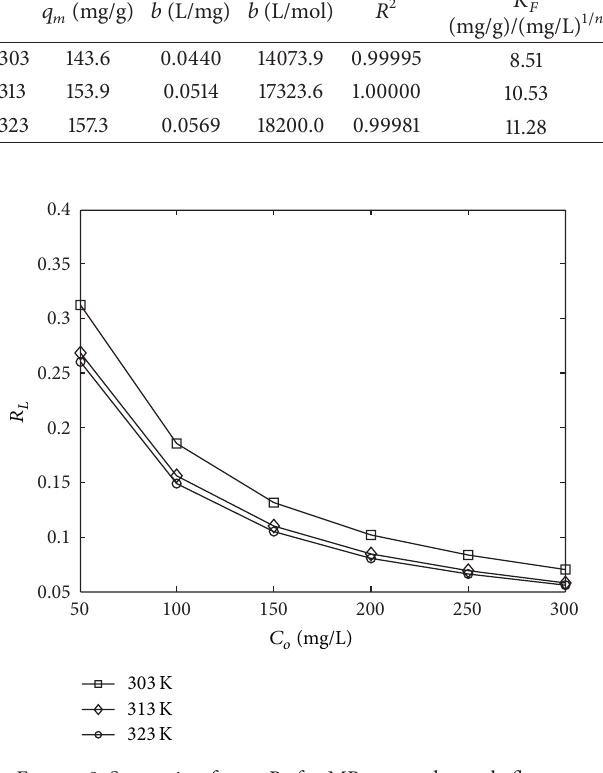
where 𝐵 = (𝑅𝑇/𝑏) , 𝑇 (K) is the absolute temperature, and 𝑅 (8.314 KJ/Kmol K) is the universal gas constant. 𝐴 (L/mg)